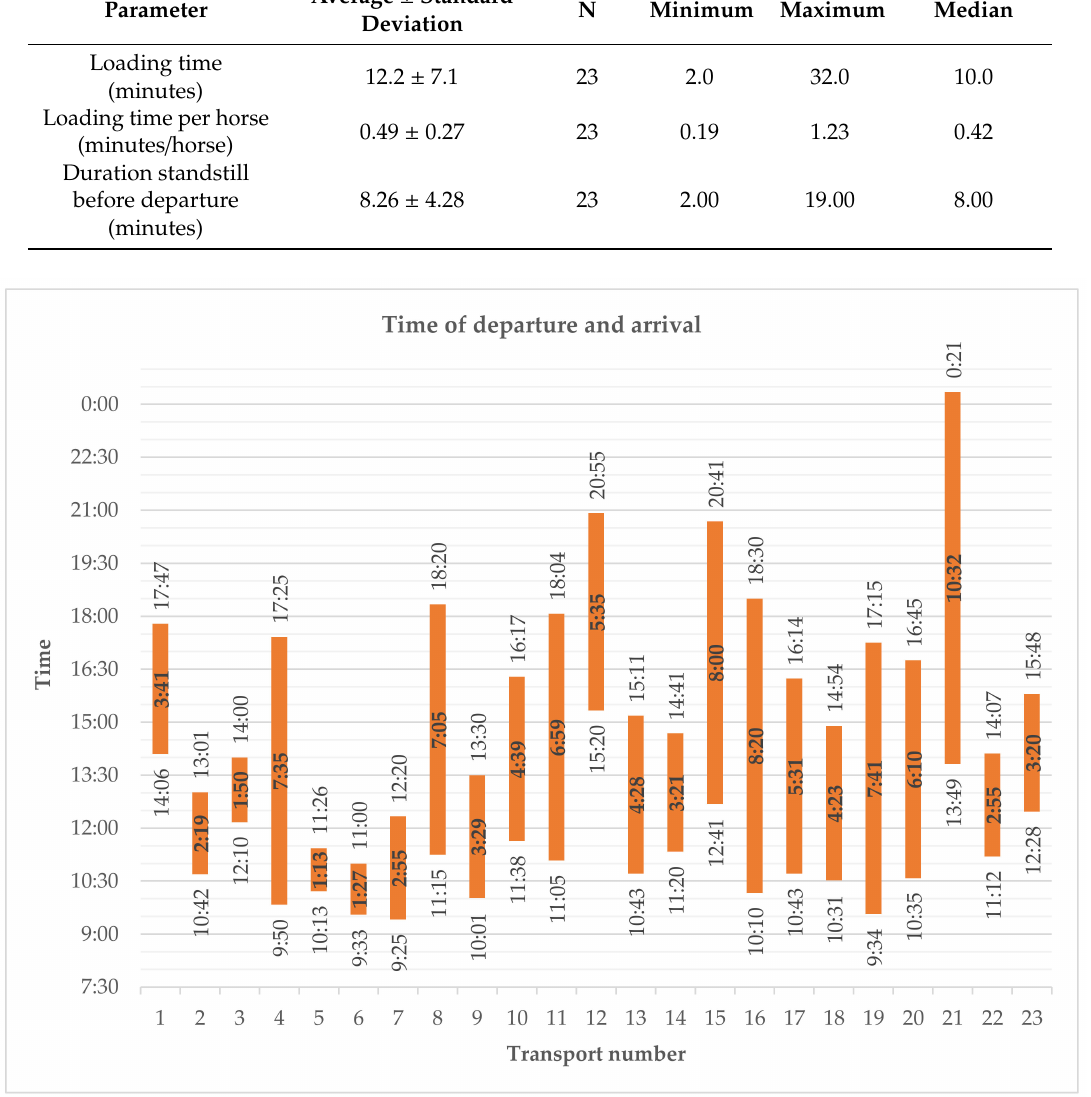
Figure 2. Arrival and departure times of the monitored transports. The duration of the transports is mentioned in the coloured bars. The transport numbers are the same as used in Tables A3 and A4 in the Appendix